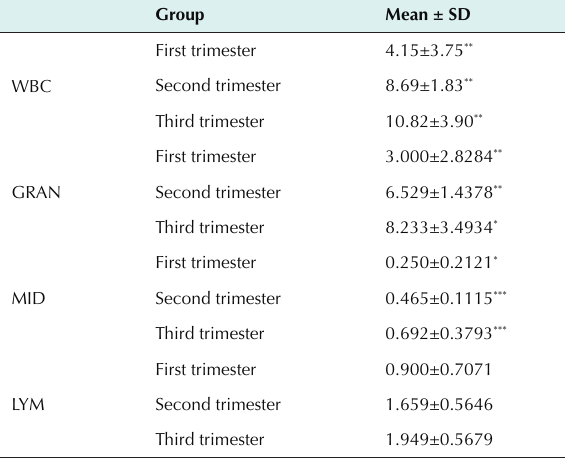
Table 5. Leukogram in 1 st , 2 nd , and 3 rd Trimester in Preeclampsia Group